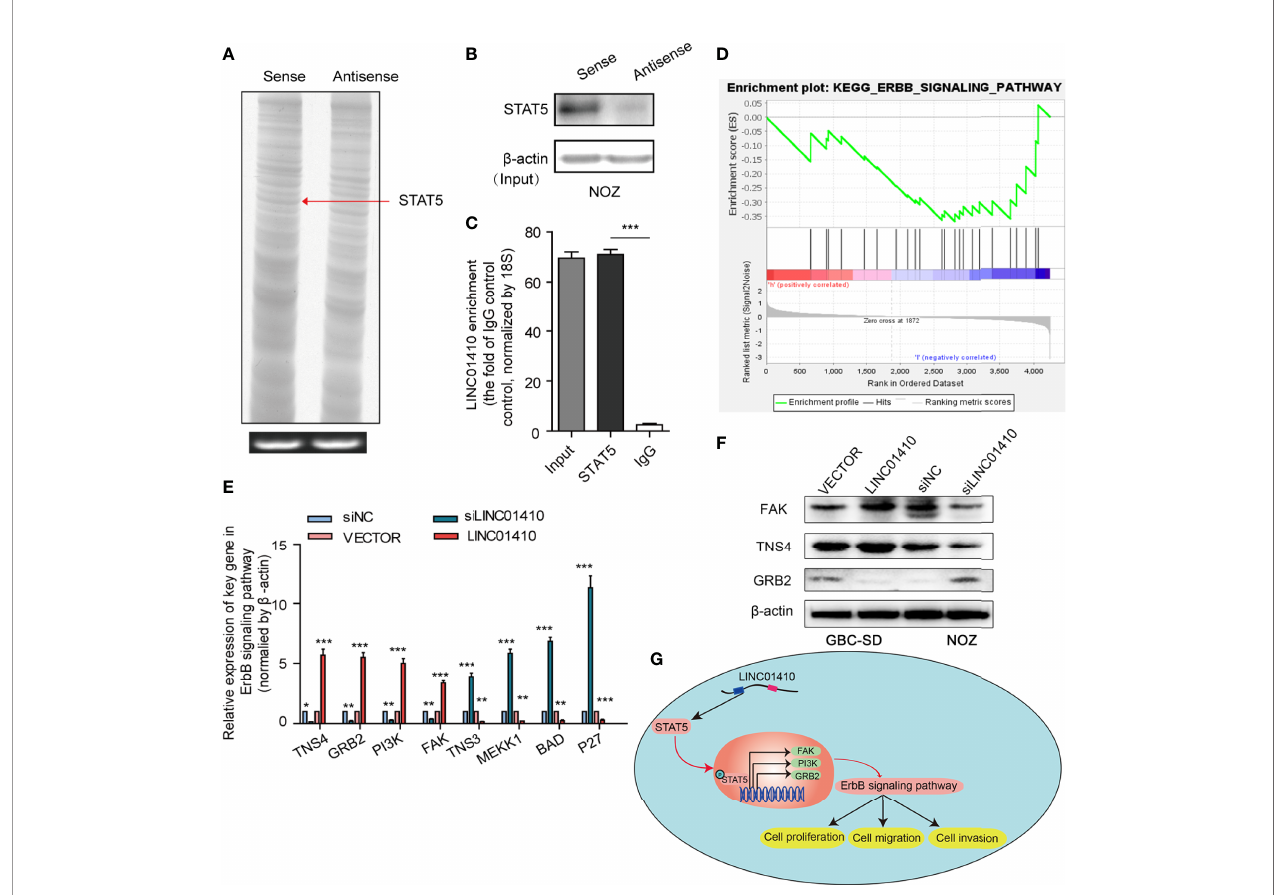
FIGURE 7 | STAT5 is a key downstream target of LINC01410. (A) Sliver staining of LINC01410-correlated proteins following RNA pull-down assay. STAT5, included in the differential band indicated by the red arrow, was identi fi ed as one of the LINC01410-correlated proteins using mass spectrometry analysis. (B) Western blot was performed to validate this interaction using anti-STAT5 antibody. b -actin was used as a negative RNA control. (C) RIP assay was performed to recover the interaction of LINC01410 and STAT5. (E) GSEA analysis of ErbB signaling pathway signatures in the GSE76633 dataset. (E, F) The mRNA (E) , and protein levels (F) of target genes involved in the ErbB signaling pathway detected by RT-PCR and Western blot, respectively. (G) Schematic model showing LINC01410-based signaling pathway in GBC cells proliferation, migration, and invasion. *p < 0.05; **p < 0.01; ***p <